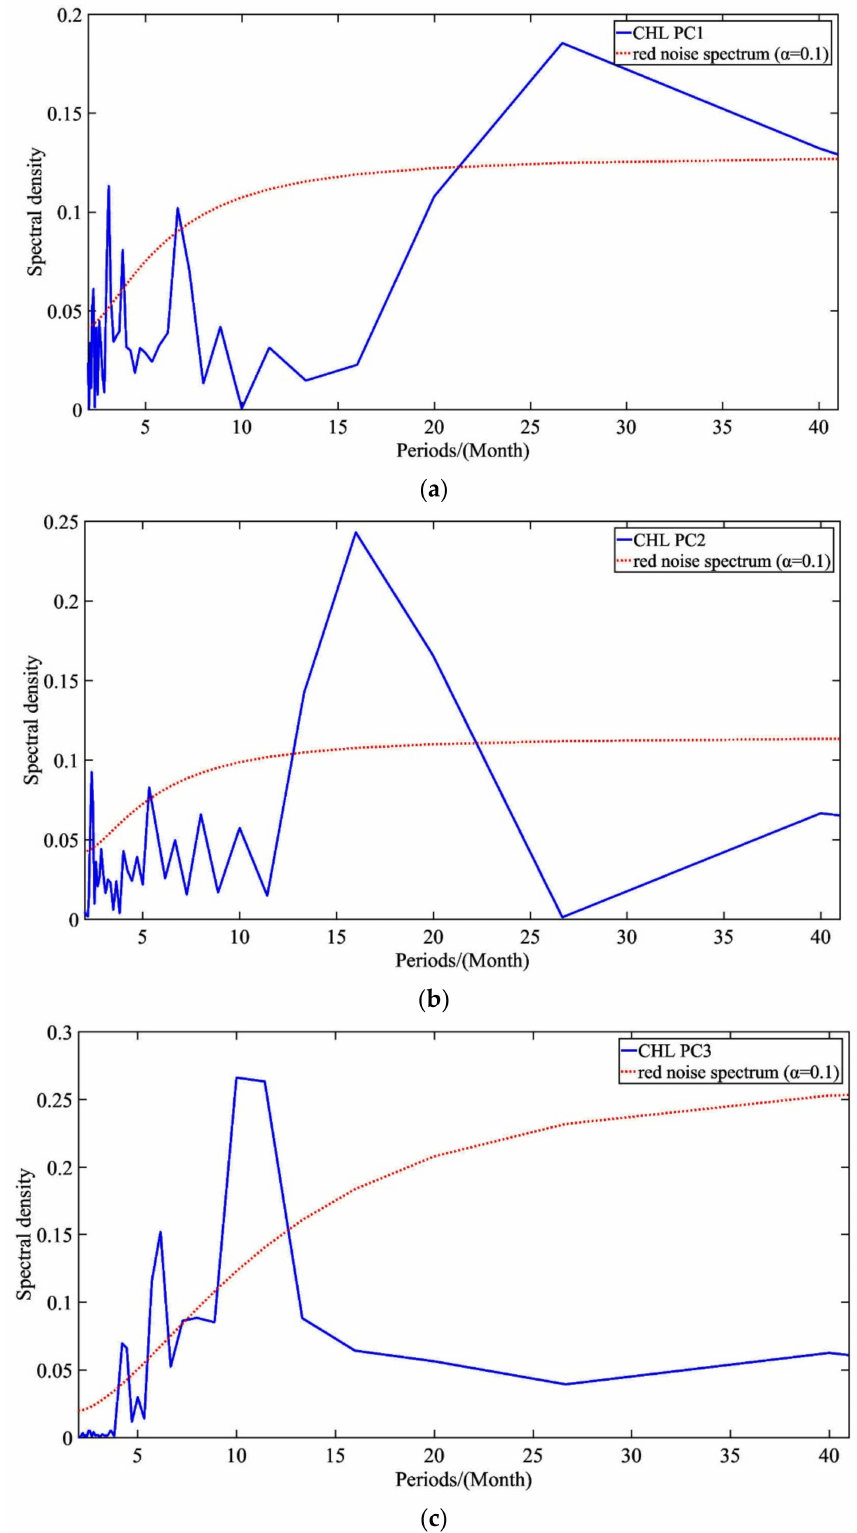
Figure 5. The power spectrum of principal components with red noise standard spectrum of 90% significance level (red dotted line). ( a ) PC1; ( b ) PC2; ( c ) PC3. The spatial pattern of S-EOF1 (Figure 3a) shows that Chla in the northern Indian Ocean was dominated by negative anomalies on the whole, and significant positive